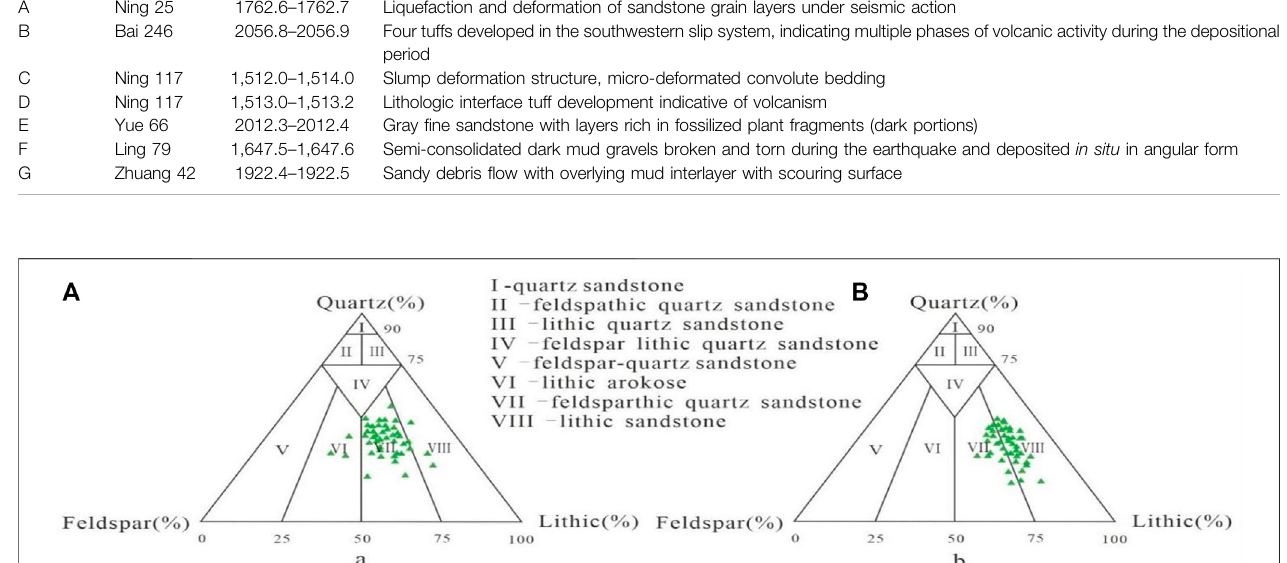
TABLE 8 | The well name, depth, and phenomenon description of Figure 7 . See Figure 1 for the locations of wells. Figure 3